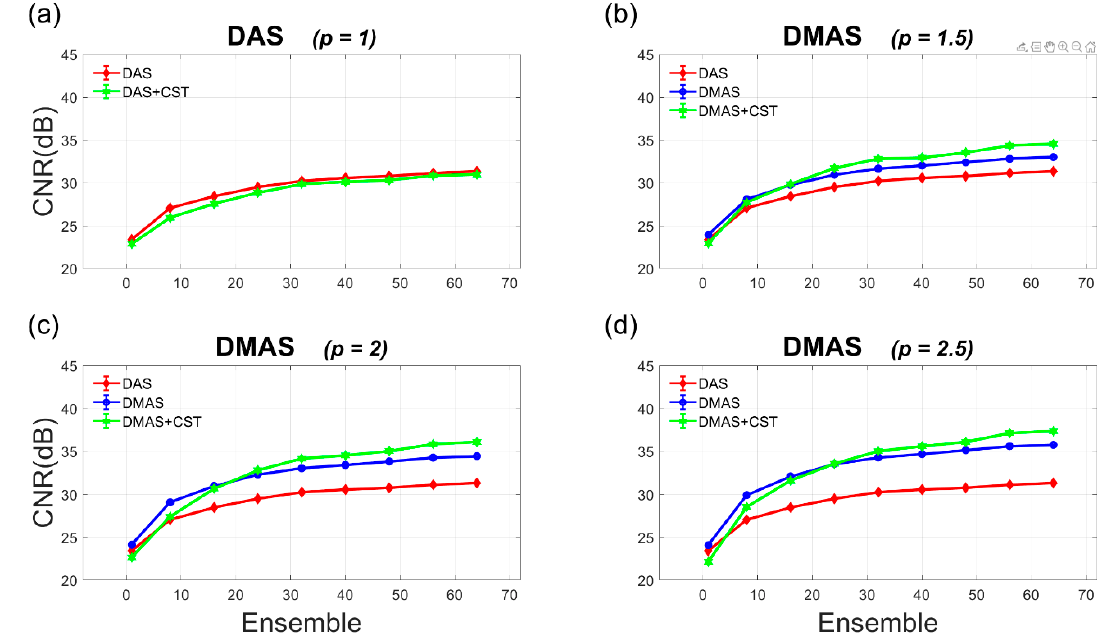
Figure 11. Quantitative analysis of Doppler CNR in the experiments as a function of ensemble number for ( a ) DAS beamforming and ( b – d ) DMAS beamforming with the p value of 1.5, 2.0, and 2.5, respectively.